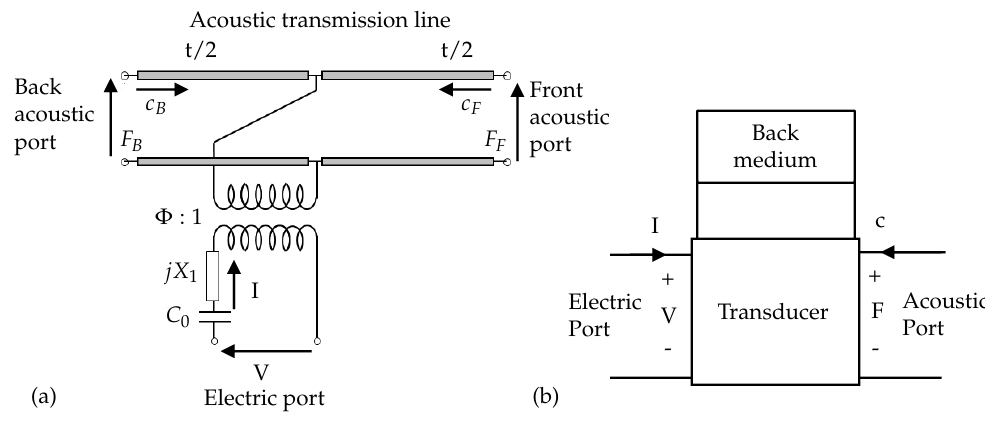
Figure 2. ( a ) KLM model of the transducer. ( b ) Two-port representation of a three-port KLM model of the transducer, when the back acoustic port is closed with an